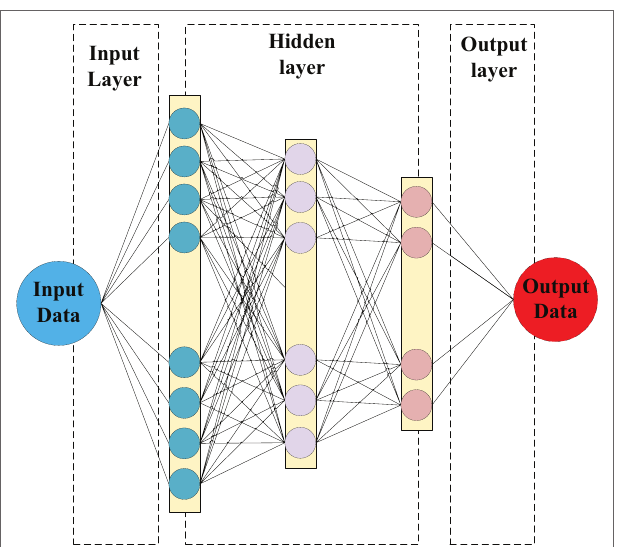
C t − 1 is the output data of the previous neural unit. Figure 12 is the structure of the forget gate (Chen et al., 2020). The data saved in the hidden layer can be selectively saved according to the sign function. f t is the trigger output, and the solution is shown in Figure 12 :